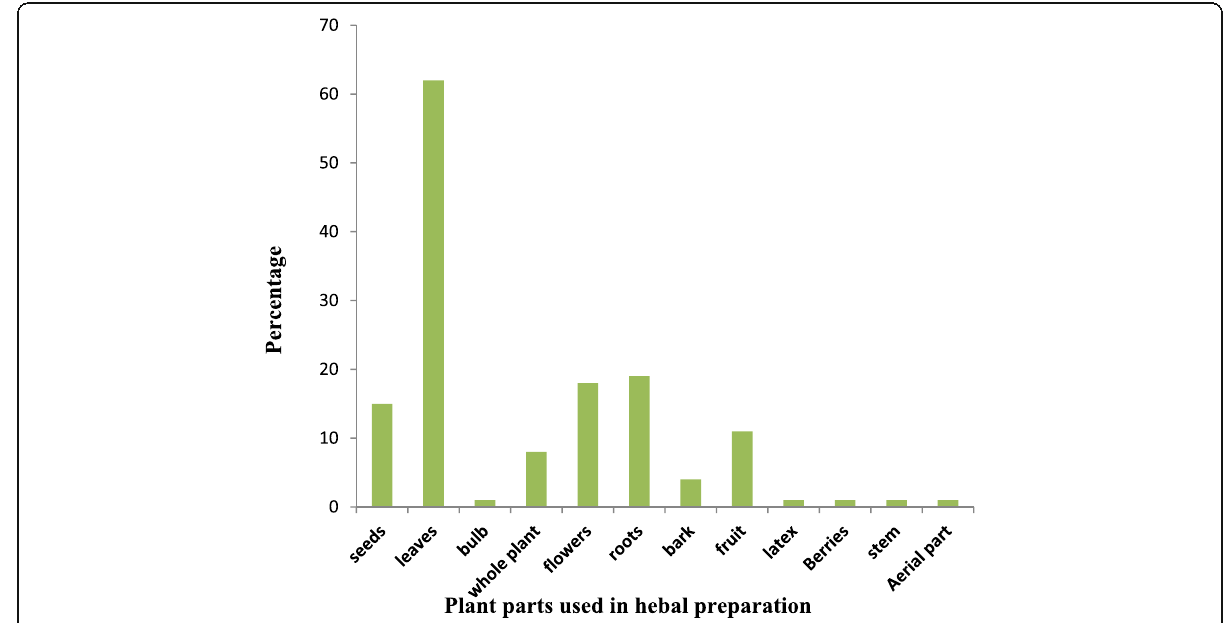
Fig. 3 Medicinal plant parts utilized for skin disorders in Northern Pakistan